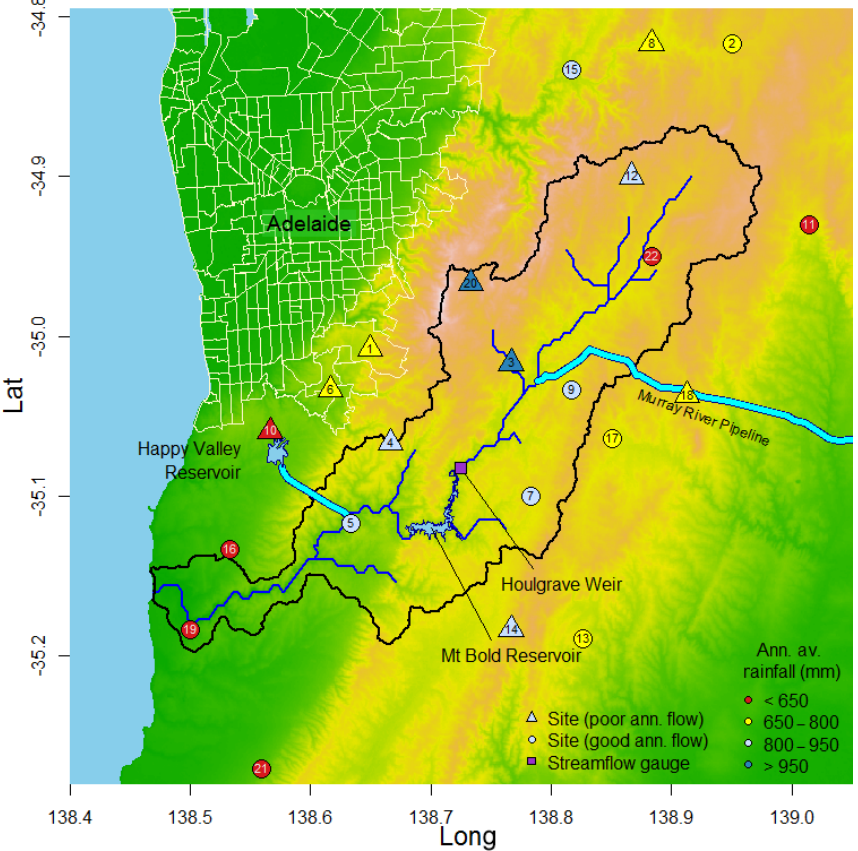
Figure 5. Onkaparinga catchment, South Australia. Sites indicated by triangles are explored in greater detail in this paper due to the relatively poorer ability of simulated rainfall to reproduce virtual-observed annual streamflow totals at these sites.